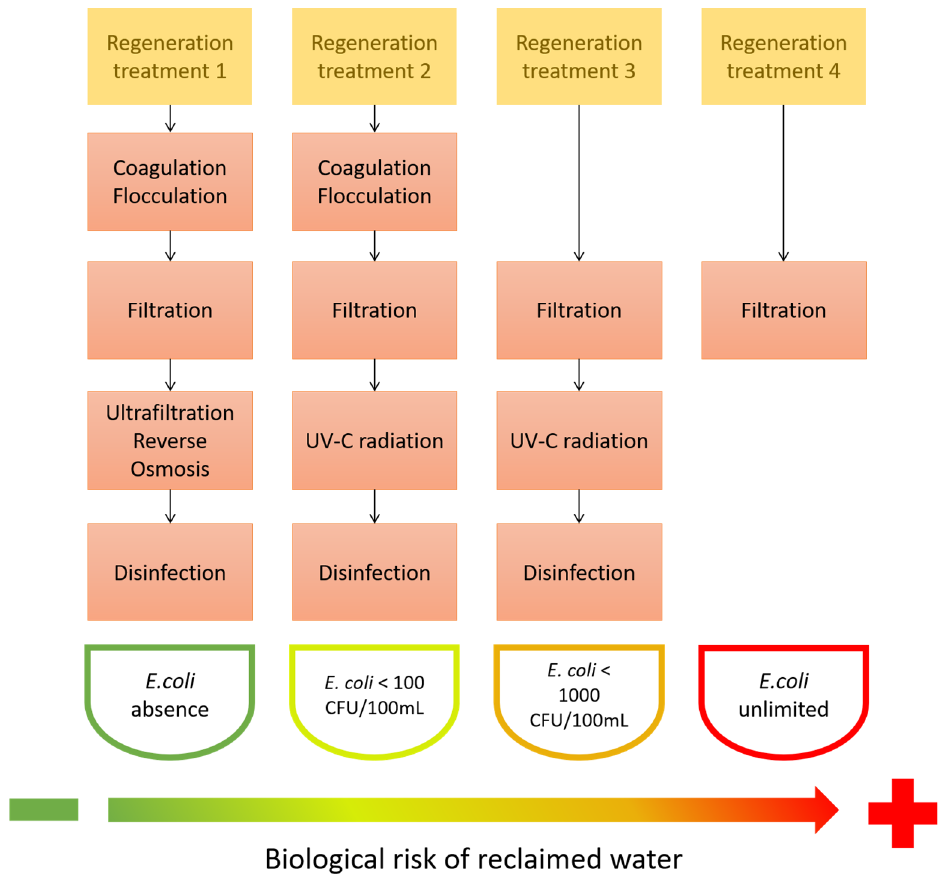
Figure 2. Proposal of wastewater reclamation line and biological risk associated with reclaimed water. Adaptation from